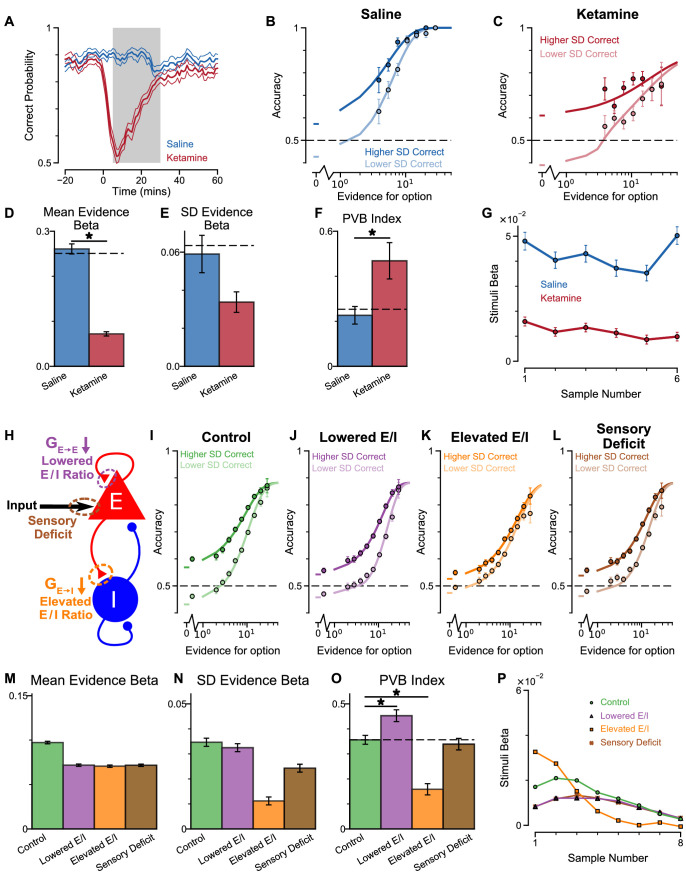
Predictions for E/I perturbations of the Spiking Circuit Model, with built-in Monkey A lapse rate, compared with Monkey A behaviour.For each circuit model (control, lowered E/I, elevated E/I, sensory deficit), a proportion of trials are selected and the corresponding choices are randomly shuffled to one of the two choices, with the proportion determined by the empirically measured lapse rate for Monkey A. The regression weights (M–P) are then calculated from the revised choices of the circuit model using the equations without lapse rate (Equations 4 and 5) to allow direct comparison with the subject data which did not control for lapse rate in Figure 8—figure supplement 1. The choice accuracy (dots in I-L) is similarly calculated for the revised choices of the circuit model, while the psychometric fit functions (lines in I-L), which are for visualisation purposes only, are fitted using an equation which incorporated the same fixed lapse rate (Equation 12).These procedures are repeated 100 times for each circuit model, with the average values taken. (A–G) Monkey A data under saline and ketamine injection. The data are identical to that in Figure 8—figure supplement 1, and is repeated here for comparison to the model. Note that the psychometric fit function in (C) here is modified to incorporate a lapse effect for better comparison as explained above (see Materials and methods, Equation 12). (H) Model perturbation schematic. Three potential perturbations are considered: lowered E/I (via NMDA-R hypofunction on excitatory pyramidal neurons), elevated E/I (via NMDA-R hypofunction on inhibitory interneurons), or sensory deficit (as weakened scaling of external inputs to stimuli evidence).(I–L) The regular-trial choice accuracy for each of the circuit perturbations (dark colour for when the ‘Higher SD’ stream is correct, light colour for when the ‘Lower SD’ stream is correct). Note that the psychometric fit functions here are modified to incorporate a lapse effect for better comparison as explained above (see Materials and methods, Equation 12). (M–O) Regression analysis on the regular trial choices of the four models, using evidence mean and evidence variability to predict choice (see Materials and methods, Equation 5). (M) The mean evidence regression coefficients in the four models. Lowering E/I, elevating E/I, and inducing sensory deficits similarly reduce the coefficient, reflecting a drop in choice accuracy. (N) The evidence standard deviation regression coefficients in the four models. All three perturbations reduce the coefficient, but to a different extent. (O) The PVB index (ratio of evidence standard deviation coefficient over mean evidence coefficient) provides dissociable predictions for the perturbations. The lowered E/I circuit increases the PVB index relative to the control model (permutation test, p<10−5), while the elevated E/I circuit decreases the PVB index (permutation test, p<10−5). The PVB index is roughly maintained in the sensory deficit circuit (permutation test, p=0.4718). The dashed line indicates the PVB index for the control circuit, * indicates a significant difference when the PVB index is compared with the control circuit. (P) The regression weights of stimuli at different time-steps for the four models (see Materials and methods, Equation 4). All errorbars indicate the standard error.